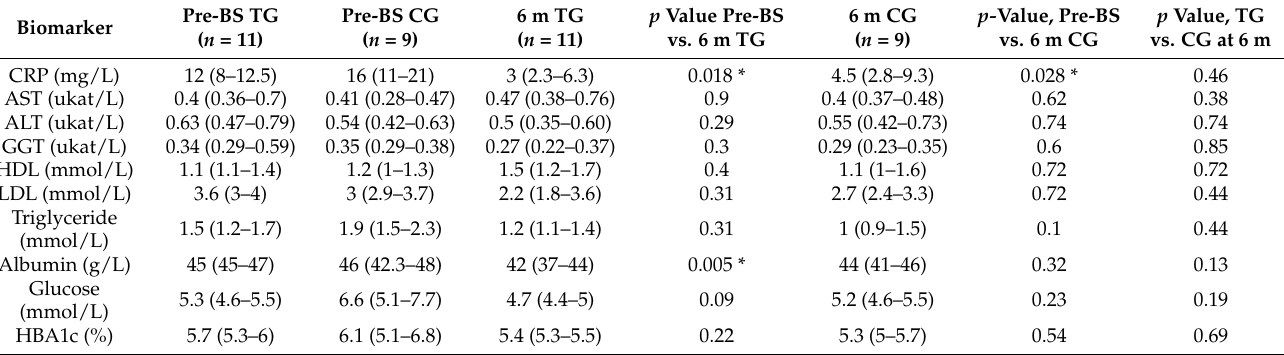
Table 5. Biochemical parameters of bariatric surgery patients before and 6 months after the